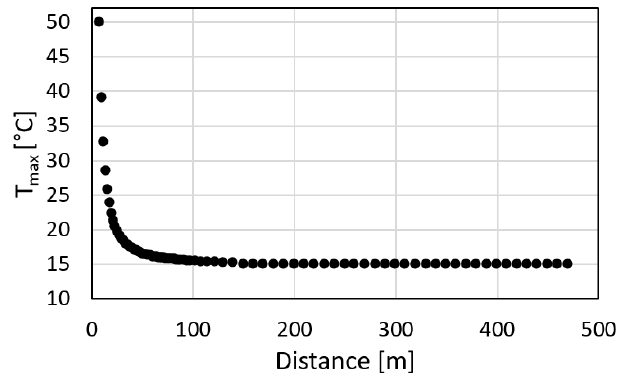
Figure B1. Results for calculated maximum temperatures in the MITRAS domain in distance downwind from the stack for a case of a 400 ◦ C plume with an ambient temperature of 15 ◦ C. The values closer to the stack are not shown for clarity. The thermic effect on the plume rise due to the hot exhaust gas vanishes at around 100m distance from the